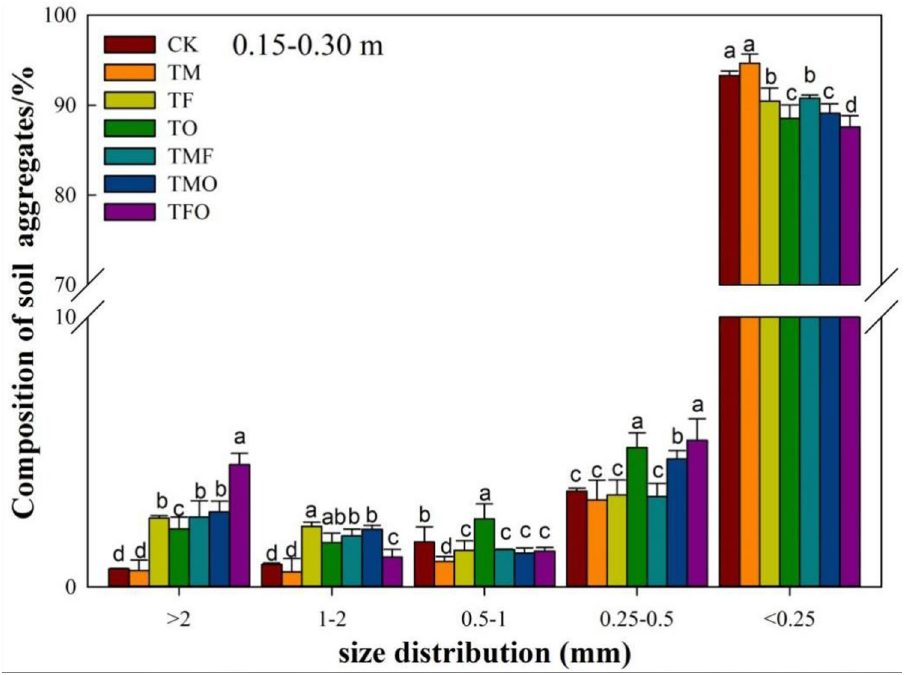
Figure 3. Percentage (%) of soil water-stable aggregates under the application of different improved materials at 0.15–0.30 m Layer. CK: no improved material; TM: maturing agent (ferrous sulfate); TF: fly ash; TO: organic fertilize; TMF: maturing agent + fly ash, TMO: maturing agent + organic fertilizer; TFO: fly ash + organic fertilizer. Different lowercase letters represent significant differences among different improved material treatments in the same particle-size aggregates.